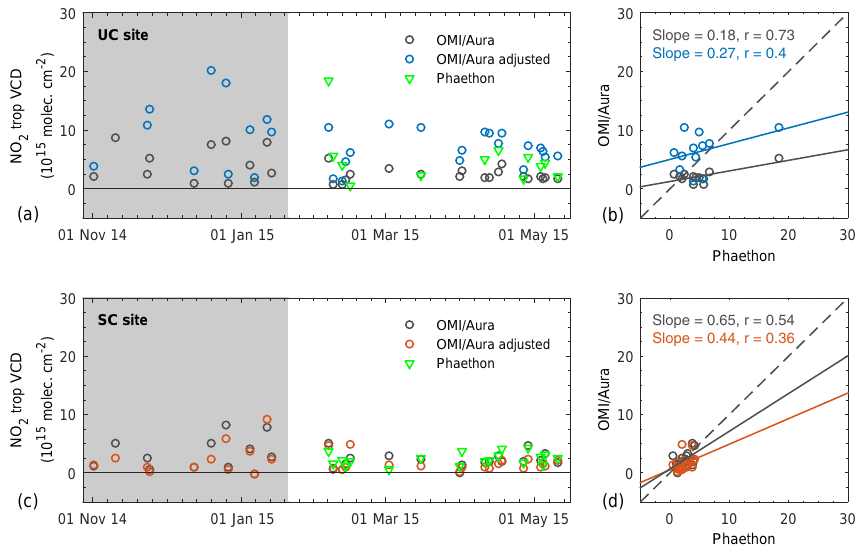
Figure 12. Same as Fig. 11 but for the UC and SC sites and the period 20 January to 11 May 2015.